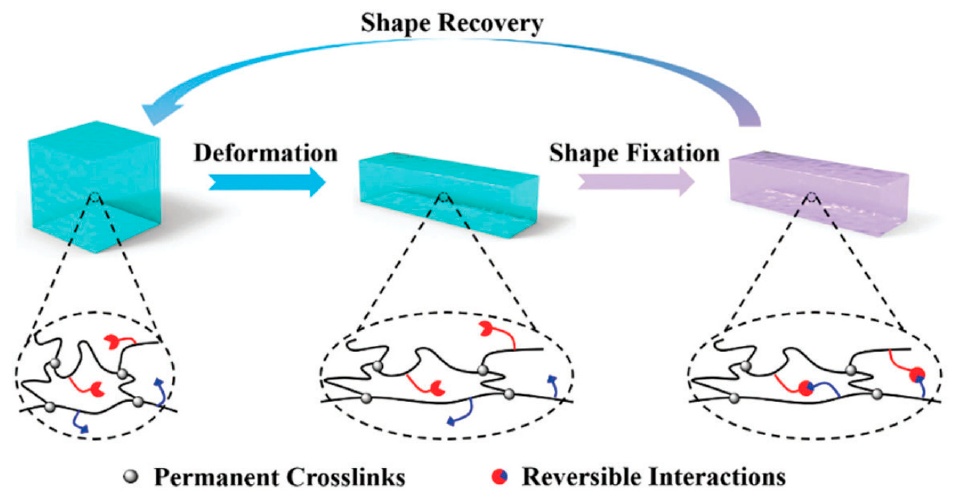
Figure 10. Mechanism of SSMHs: A crosslinked hydrogel can be deformed under an external stress and the temporary shape fixed by an external stimulus that induces the establishment of reversible interactions. A second stimulus may break the interactions and the material reverts to its permanent shape. Reproduced with permission from [173], copyright 2017 RSC.